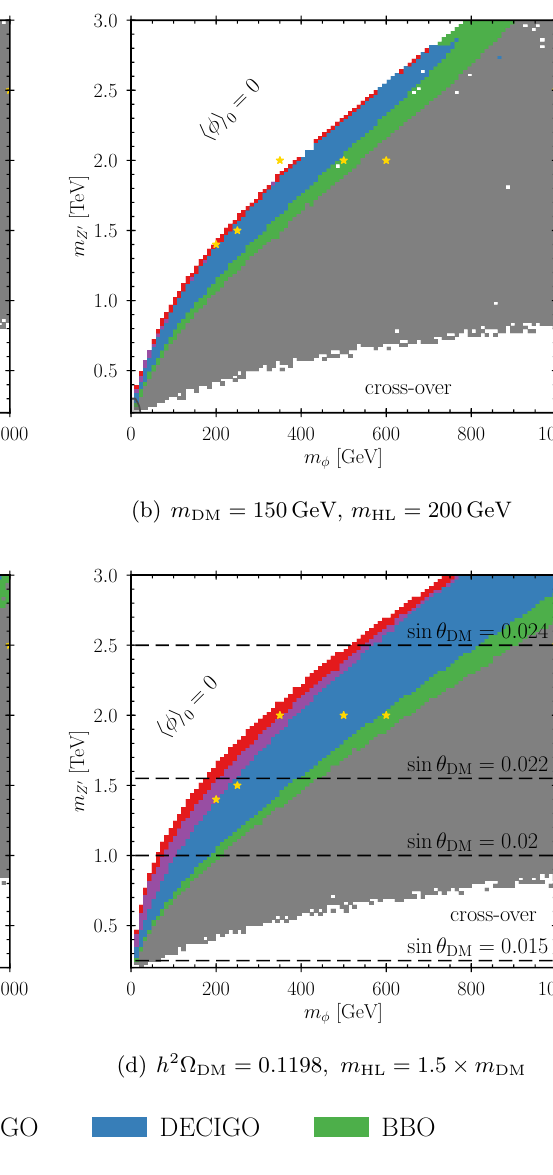
Figure 21 . Sensitivity of space-based GW observatories to the stochastic background from the lepton number breaking PT (for negligible portal couplings) in the m (cid:30) m Z 0 plane. In the colored (cid:0) regions, the GW can be detected by LISA (red), B-DECIGO (purple), DECIGO (blue), and BBO (green), respectively. In the gray region, the stochastic background is not detectable. The SNRs of the points marked by a star are listed in appendix C. The gray shaded regions (below the dark gray, solid line) in (cid:12)gures 21(b) and 21(c) are excluded as the potential is unstable. In (cid:12)gure 21(d), the DM mass is set to a value reproducing the measured DM abundance at each parameter point. The dashed lines indicate the exclusion reach of XENON1T for di(cid:11)erent values of the DM mixing angle (cid:18) DM